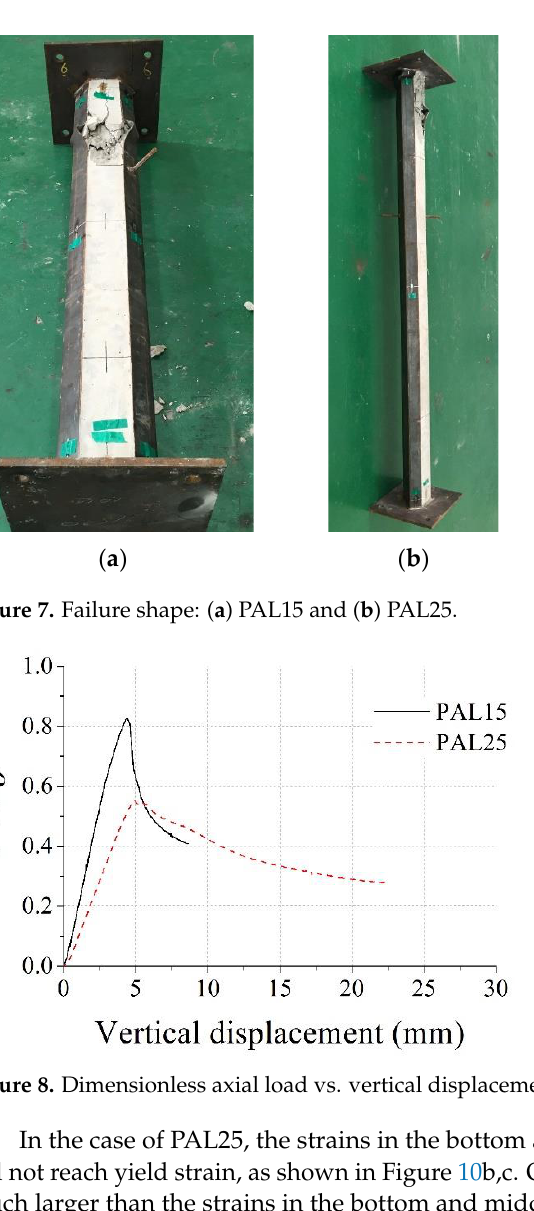
Figure 8. Dimensionless axial load vs. vertical displacement for PAL15 and PAL25.